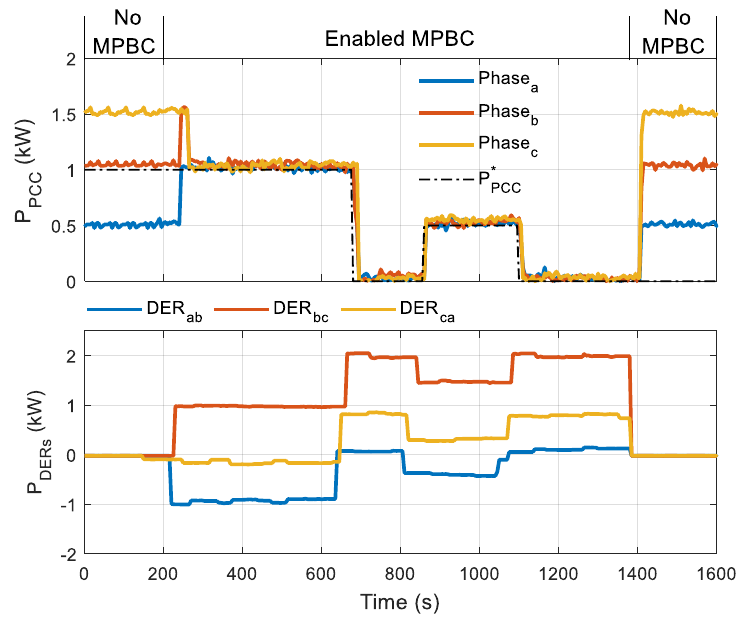
Figure 11. Imbalance compensation: PCC active power and DER power during GOS mode.